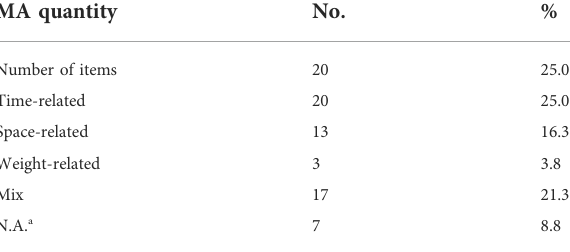
TABLE 1 Ways to express macroplastics ’ quantity (MA quantity) observed in the fi eld, reported in the literature. The second column indicates the number of articles (No.), also reported in percentage (%) in the last column. MA quantity